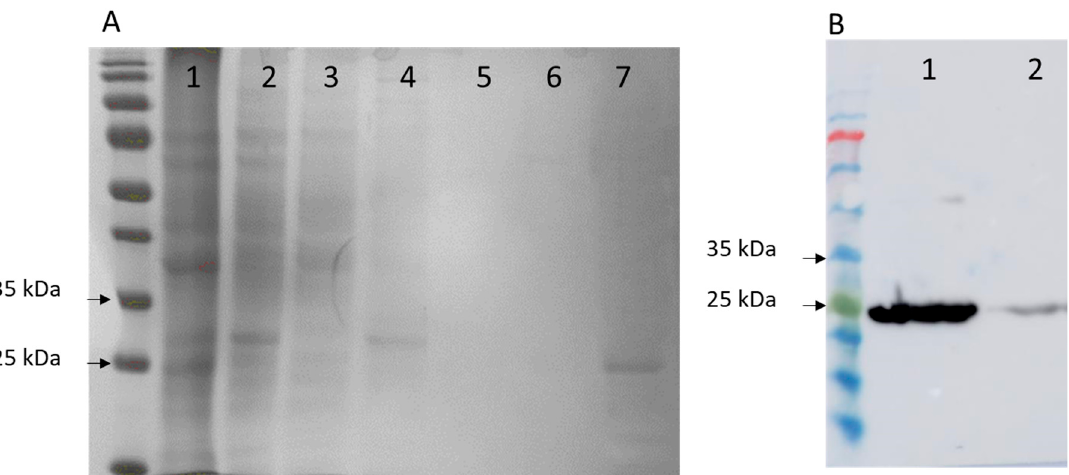
Figure 3. SDS-PAGE gel (14%), panel A, and Western blo tt ing showing the immunodetection of Cast_Gnk2-like protein, panel B. Hyper-expression and purification of Cast_Gnk2-like protein ob- tained using the E. coli BL21 (DE3) pLysS transformed with pET15b_Cast_Gnk2, lane 1: Cell pellet after sonication; lane 2: cell free extract; lane 3 to 6: fractions of the column washing procedure wash; lane 7: purified recombinant enzyme, 0.5 mg/mL ( A ). Western blotting showing the immunodetec- tion of Cast_Gnk2-like protein using total cell extract after sonication, lane 1—insoluble fraction, lane 2—soluble fraction ( B ). The molecular masses (kDa) of protein standards (NZYTech Ltd., Lis- bon, Portugal) are indicated.